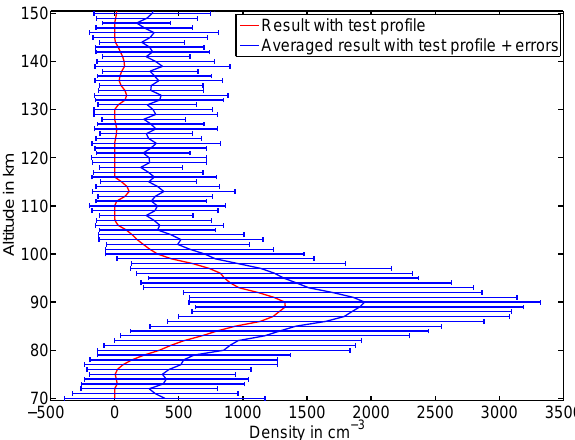
Fig. 24. Retrieval of Mg (285.2nm). The same methods as in Fig. 21 are applied. However, here the single measurements error is used. As for high relative errors the error propagation cannot be approx- imated to be linear and nonlinearities in the forward model lead to a shift of the mean to higher values. Therefore, a certain averaging of the data is needed before applying the retrieval algorithm. Note that the error bars estimate the error of single measurements while √ the error for the blue line is a factor 1000 ≈ 32